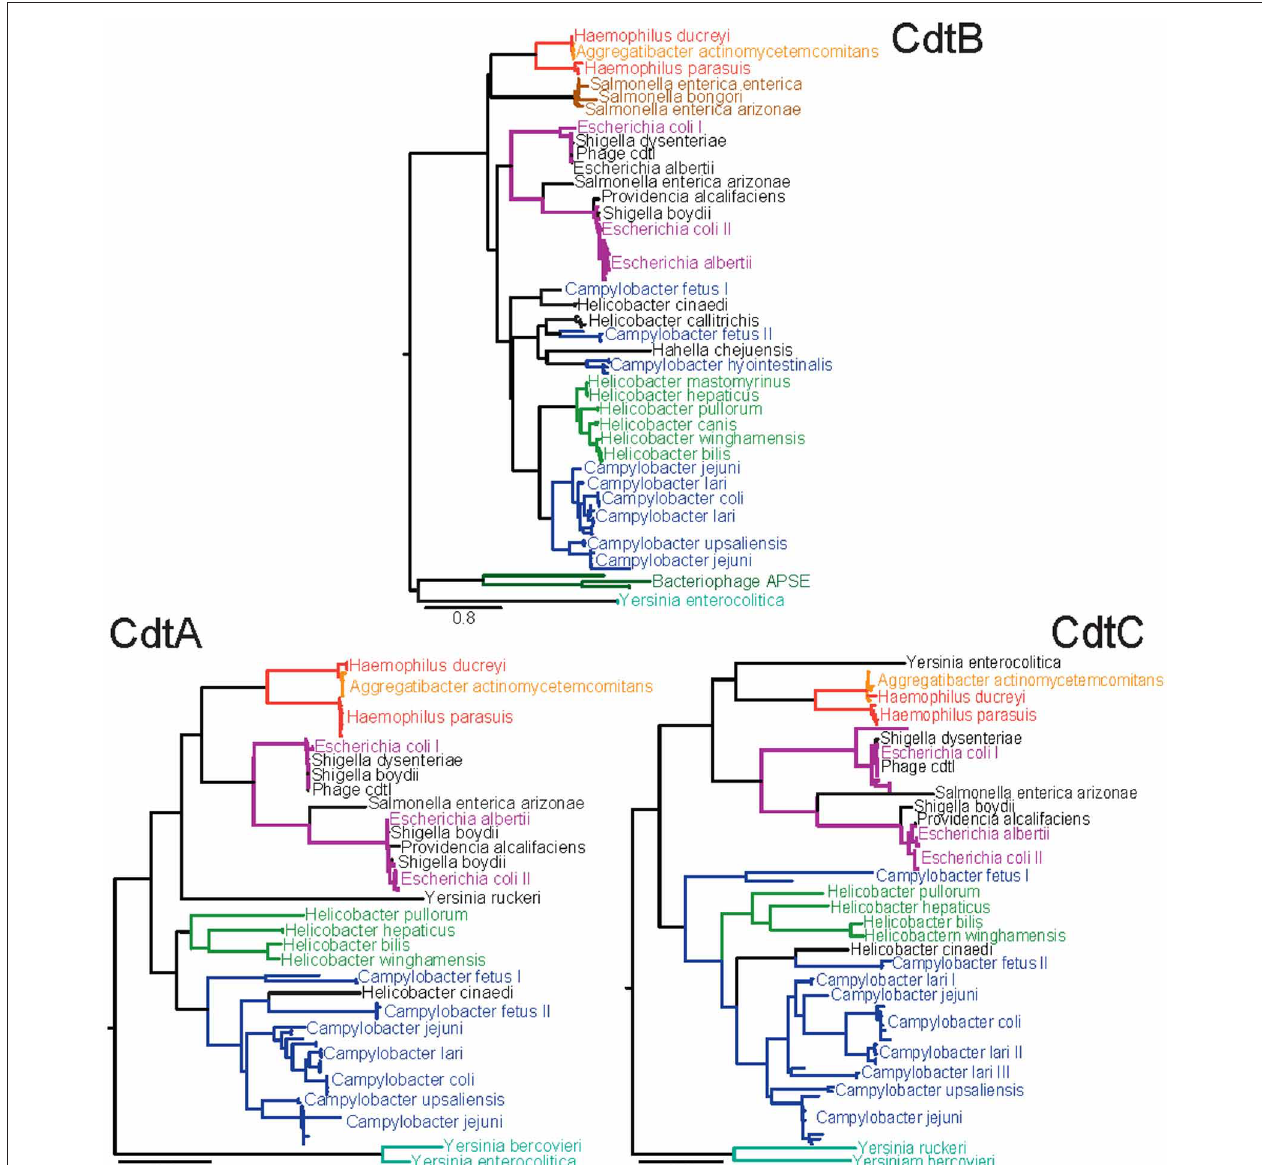
FIGURE 2 | Amino acid maximum likelihood phylogeniesof the three subunits of CDT. Sequences were extracted from the NCBI non-redundant protein database using BLAST with the criteria that sequences have at least 30% identity and 50% coverage against a known set of CDT subunit sequences from H. ducreyi, A. actinomycetemcomitans, E. coli, E. albertii, S. dysenteriae, S. enterica, C. jejuni, and H. bilus . Sequences below these threshold cut-offs were too divergent to be reliably aligned for phylogenetic